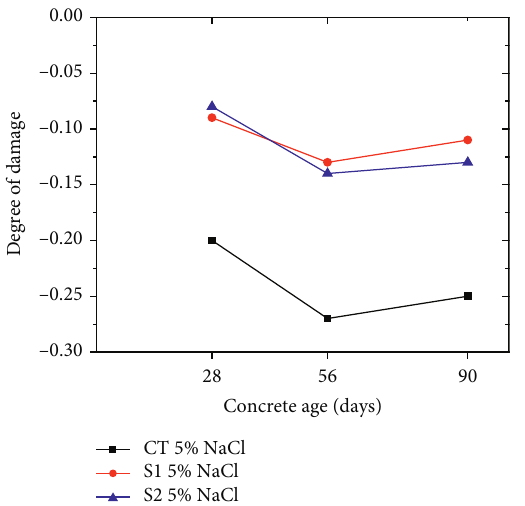
Figure 9: Degree of damage CT, S1, and S2 scoria immersed in water.